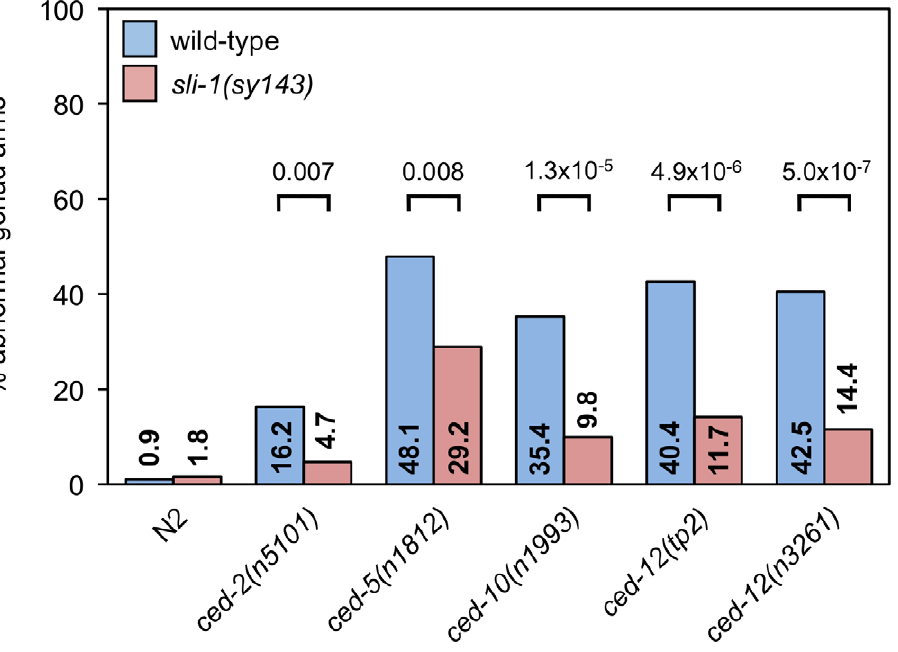
Figure 4. sli-1 mutation suppresses the DTC migration defects caused by all CED-10 Rac pathway gene mutations. The gonads of young adult animals mutant for an engulfment gene with or without sli-1 mutation were observed and scored for morphology using DIC microscopy. Scoring was as described in Materials and Methods. Percentages of abnormal gonad arms are shown. More than 80 gonad arms were scored for all genotypes. p values derived using Fisher’s exact test are